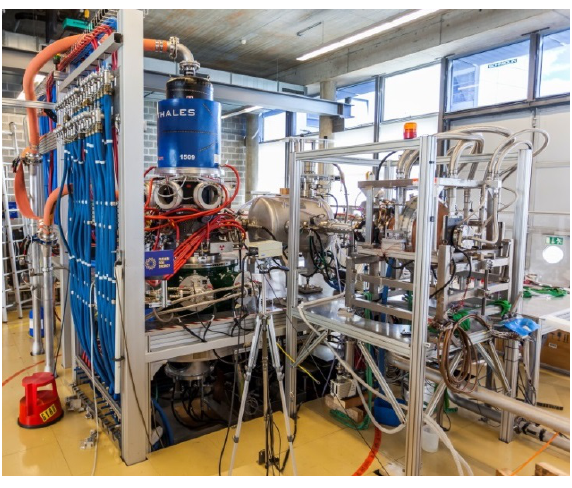
Fig. 2. TH1509 gyrotron prototype installed in the SPC test stand, in Lausanne (Switzerland), with MOU and dummy load .